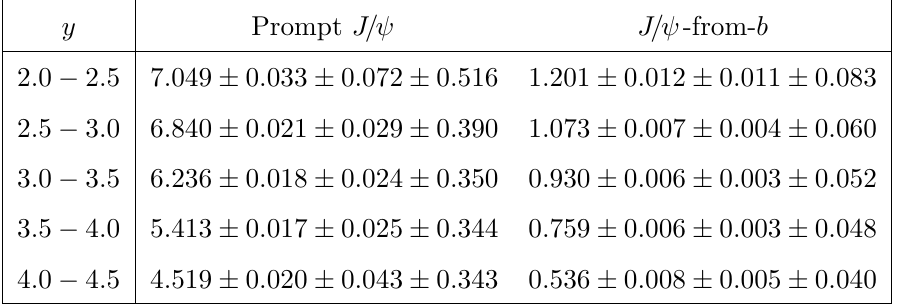
Table 8 . Di(cid:11)erential cross-sections d(cid:27)=dy (in (cid:22) b) for prompt J= and J= -from- b mesons, inte- grated over p T . The (cid:12)rst uncertainties are statistical and the second (third) are the uncorrelated (correlated) systematic